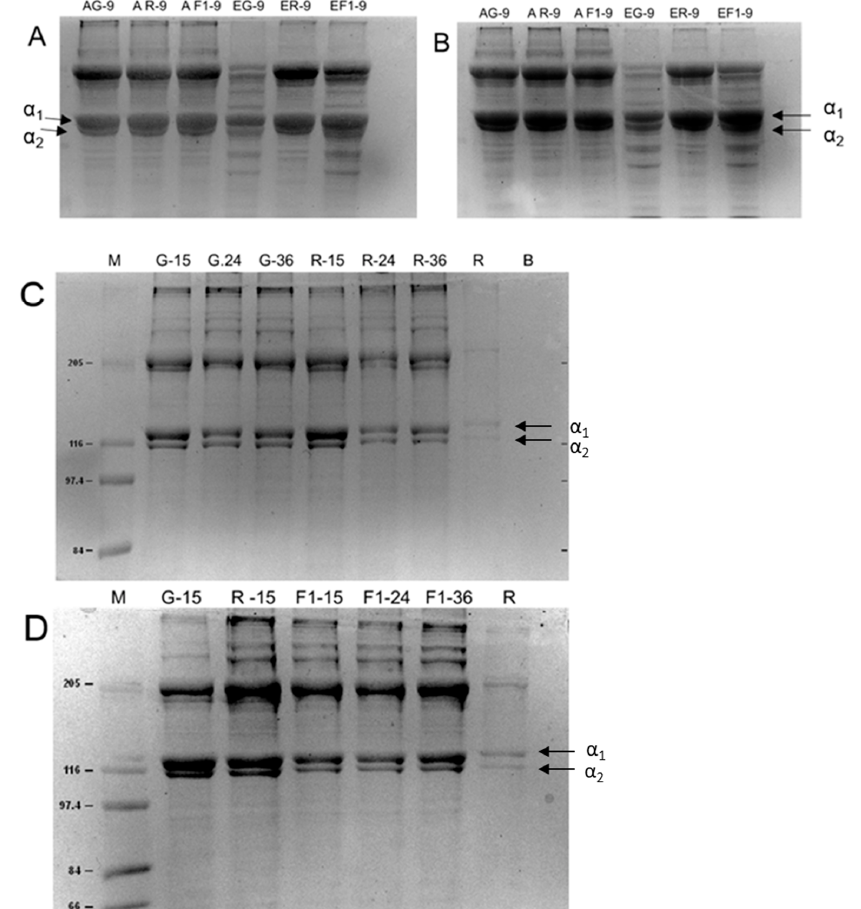
Figure 2. SDS-PAGE electrophoresis of collagen samples from red, gray, and F1 tilapia ( Oreochromis niloticus ) skin from the cross of red YY males with XX gray females. ( A ). Without mercaptoethanol from 9-month-old fish collagen ASC samples, (AG-9: ASC-Gray, AR-9: RED ASC, AF1: ASC-F1) and by the PSC collagen (EG-9: PSC-Gray, ER-9: PSC RED, EF1: PSC-F1); ( B ). With mercaptoethanol from 9-month-old fish collagen samples; ( C ). Collagen ASC, M: molecular weight marker, G-15: gray 15 months, G-24: gray 24 months, G-36: gray 36 months, R-15: Red 15 months, R-24: Red 24 months, R-36: red 36 months R: bovine skin collagen, B: Run buffer (control). ( D ). Collagen ASC, M: molecular weight marker, G-15: gray 15 months, R-15: Red 15 months, F1-15: F1 15 months, F1-24: 24 months, F1-36: F1 36 months. R: bovine skin collagen. α 1 and α 2 chains.